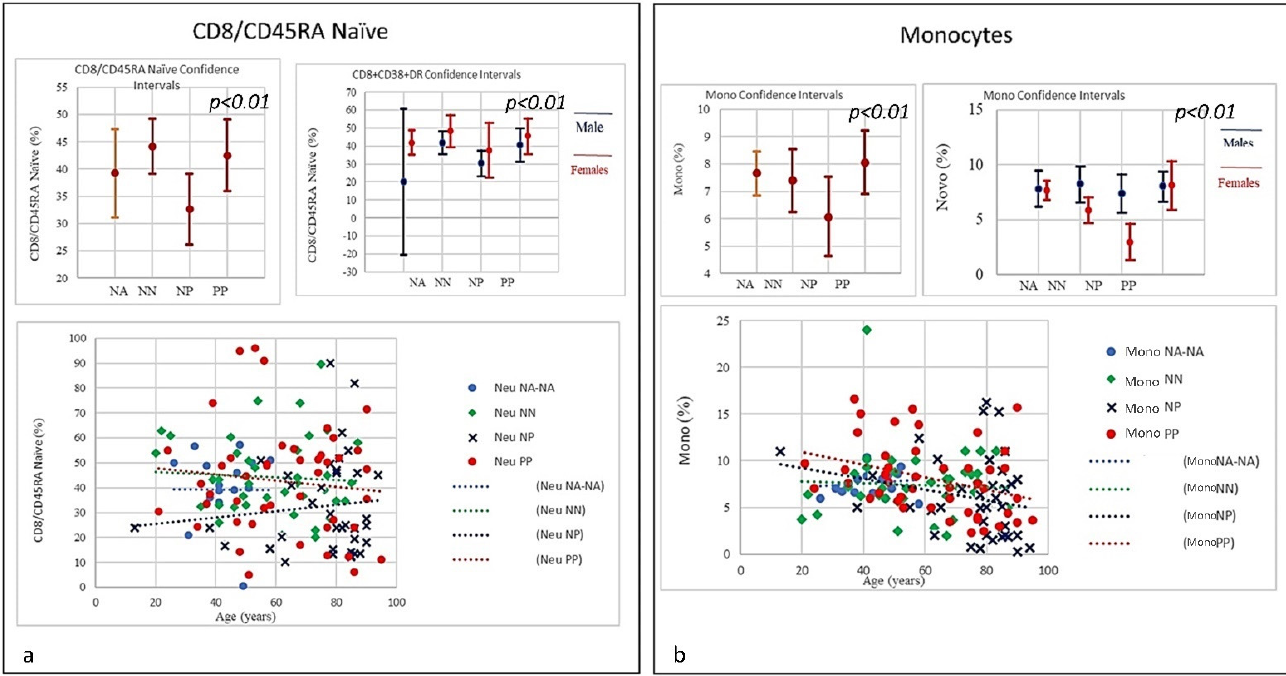
Figure 7. ( a ) Frequencies of CD8+/CD45RA Naïve level in COVID-19 patients and controls (NP, NN, and NA). The graphic shows a slight quantitative decrease in CD8 naïve for PP without correlation to age, while a quantitative increase in CD8 naïve in correlation to age in NP individuals was observed, CD8 naïve in the NP group started to increase from a lower level than PP. Though the mechanism is yet to be clarified as unlike age related changes in other T cell subsets, the stable level of T memory cells in peripheral blood may support CD8 naïve cells for long-term immunological memory, while their importance may increase together with ageing. ( b ) Frequencies of Monocytes percentage in COVID-19 Patients and Controls (NP, NN, and NA). The graph shows a decline in both PP and NP as age increases, mainly due to a general decline of naïve lymphocytes in the bone marrow and thymus as well as the expansion of incompetent memory lymphocytes.